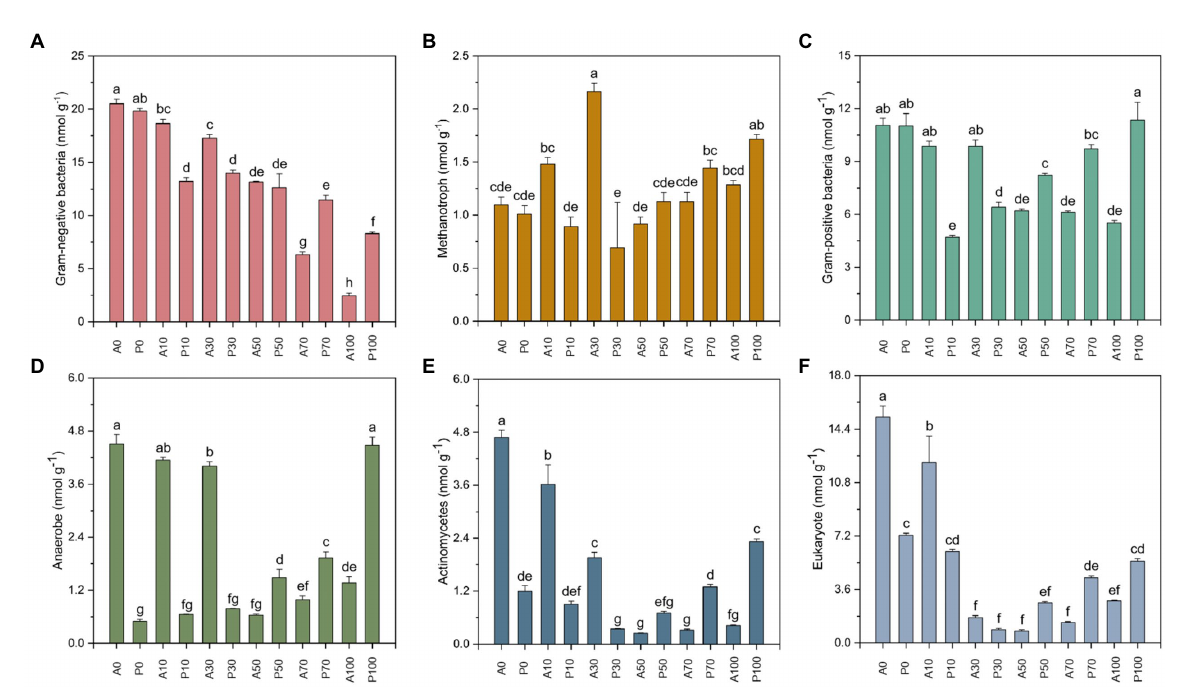
FIGURE 5 The PLFAs (nmol g − 1 ) indicated by Gram-negative (A) , Methanotroph (B) , Gram-positive (C) , Anaerobe (D) , Actinobacteria (E) , and Eukaryote (F) in different treatments on day 7. A0: Equivalent amount of methanol were added into native soil. A10: 10 mg kg − 1 atrazine-contaminated soil; A30: 30 mg kg − 1 atrazine-contaminated soil; A50: 50 mg kg − 1 atrazine-contaminated soil; A70: 70 mg kg − 1 atrazine-contaminated soil; A100: 100 mg kg − 1 atrazine-contaminated soil; P0: Equivalent amount of methanol and P. ureafaciens ZY were added into native soil; P10: 10 mg kg − 1 atrazine- contaminated soil with P. ureafaciens ZY inoculation; P30: 30 mg kg − 1 atrazine-contaminated soil with P. ureafaciens ZY inoculation; P50: 50 mg kg − 1 atrazine-contaminated soil with P. ureafaciens ZY inoculation; P70: 70 mg kg − 1 atrazine-contaminated soil with P. ureafaciens ZY inoculation; P100: 100 mg kg − 1 atrazine-contaminated soil with P. ureafaciens ZY